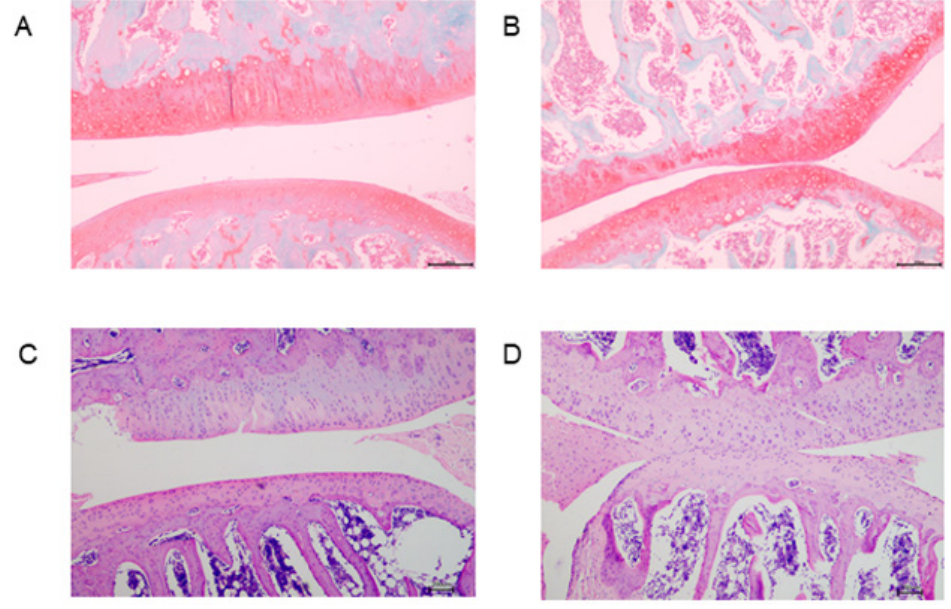
Figure 1. Histologic staining of control group and OA group. ( A , B ) Representative safranin O staining for ( A ) control group and ( B ) OA group. ( C , D ) Representative HE staining for ( C ) control group and ( D ) OA group. Scale bar, 200 µ